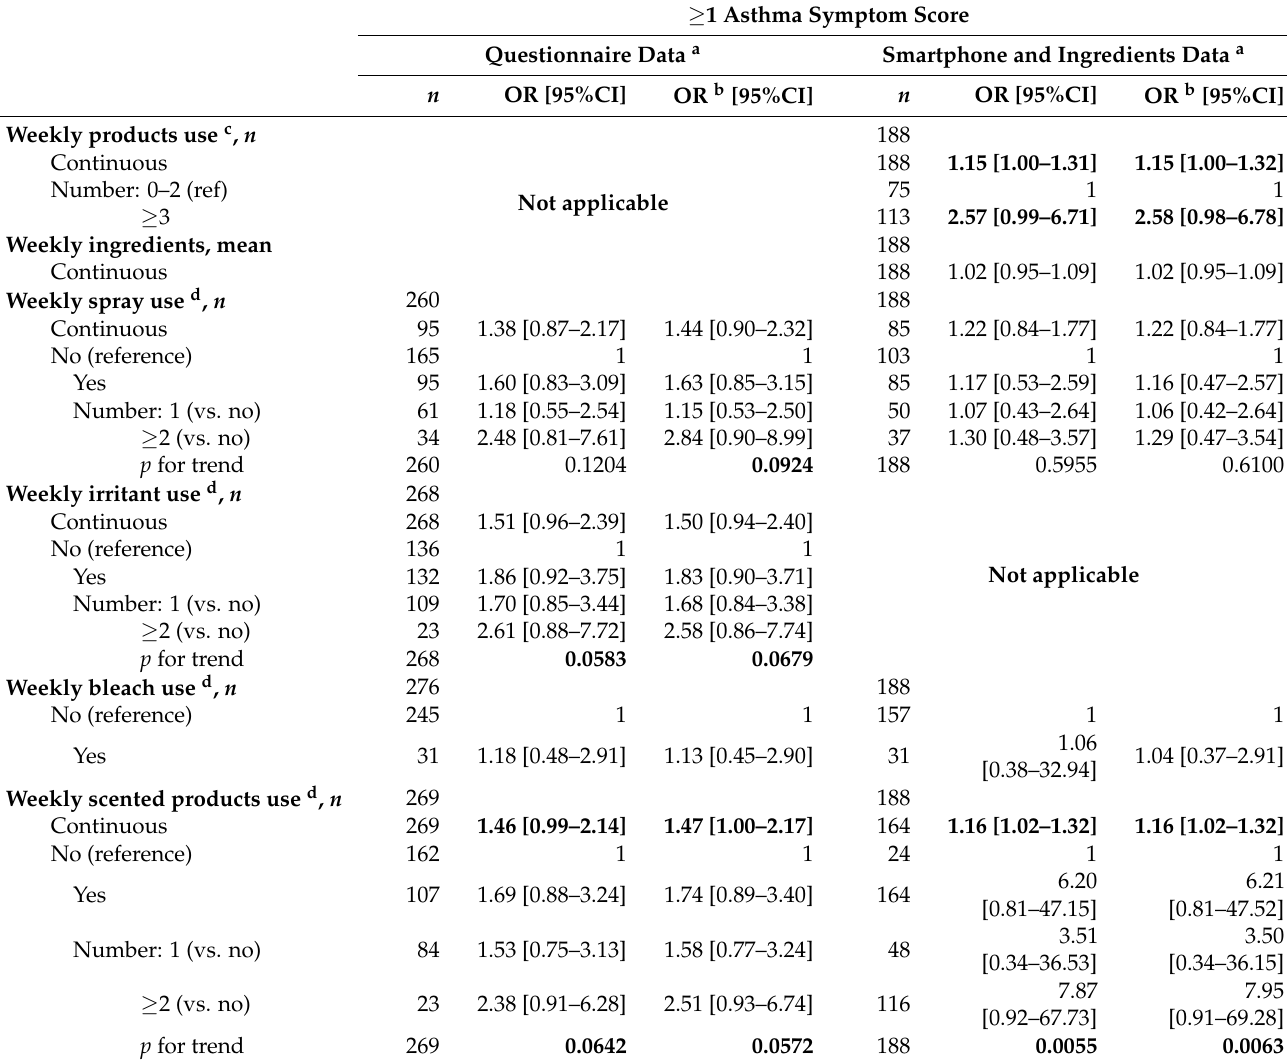
Table 4. Associations between household cleaning products use and ≥ 1 asthma symptom score, according to the methods of cleaning products use